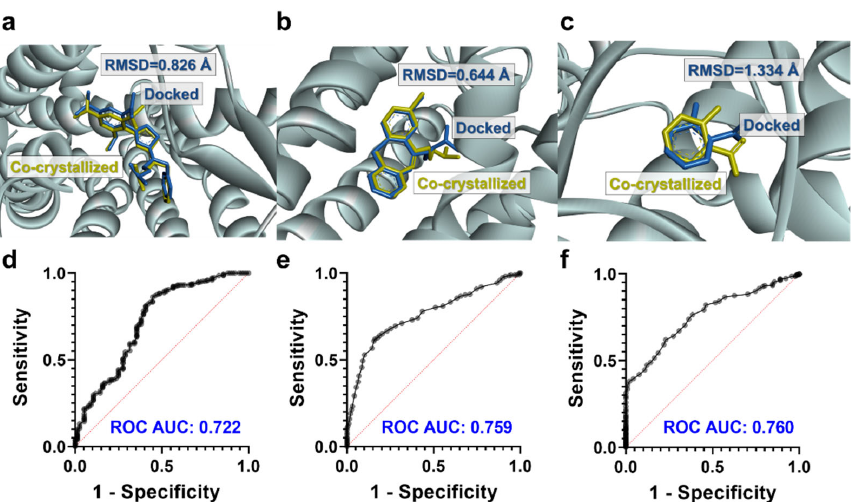
Figure 4. Docking protocol performance from experimentally evaluated ligands. The upper panels show the cartoon ribbon models with the co ‐ crystallized ligands (yellow) and the re ‐ docked ligands (blue) accompanied by the RMSD value. ( a ) Foropafant bound to PAF ‐ R (PDB file: 5ZKP). ( b ) Zotepine bound to 5 ‐ HT 2A receptor (PDB file: 6A94). ( c ) Salicylate bound to COX ‐ 2 (PDB file: 5F1A). The lower panels show the receiver operating characteristic (ROC) curves based on data obtained by a benchmarking analysis of active and inactive ligands. ( d ) Ligands against PAF ‐ R (n = 351, p < 0.0001). ( e ) Ligands against 5 ‐ HT 2A receptor (n = 449, p < 0.0001);.( f ) Ligands against COX ‐ 2 (n = 665, p < 0.0001).